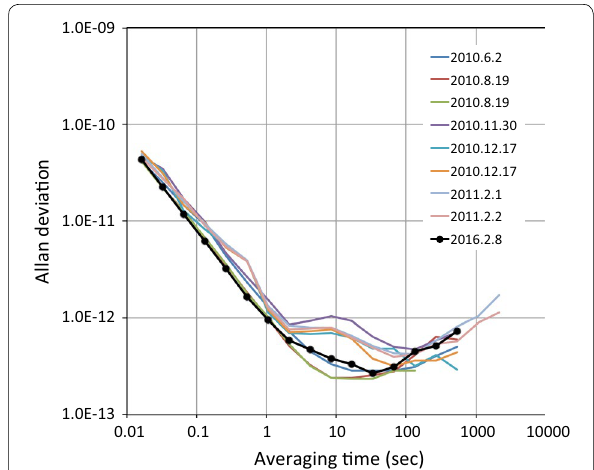
Fig. 3 Allan deviations of the downlink signal frequency measured after the launch blocks by fitting a theoretical signal spectrum (sinc func- tion) to the discrete Fourier transforms (Lipa and Tyler 1979). The resultant frequency variation is subtracted